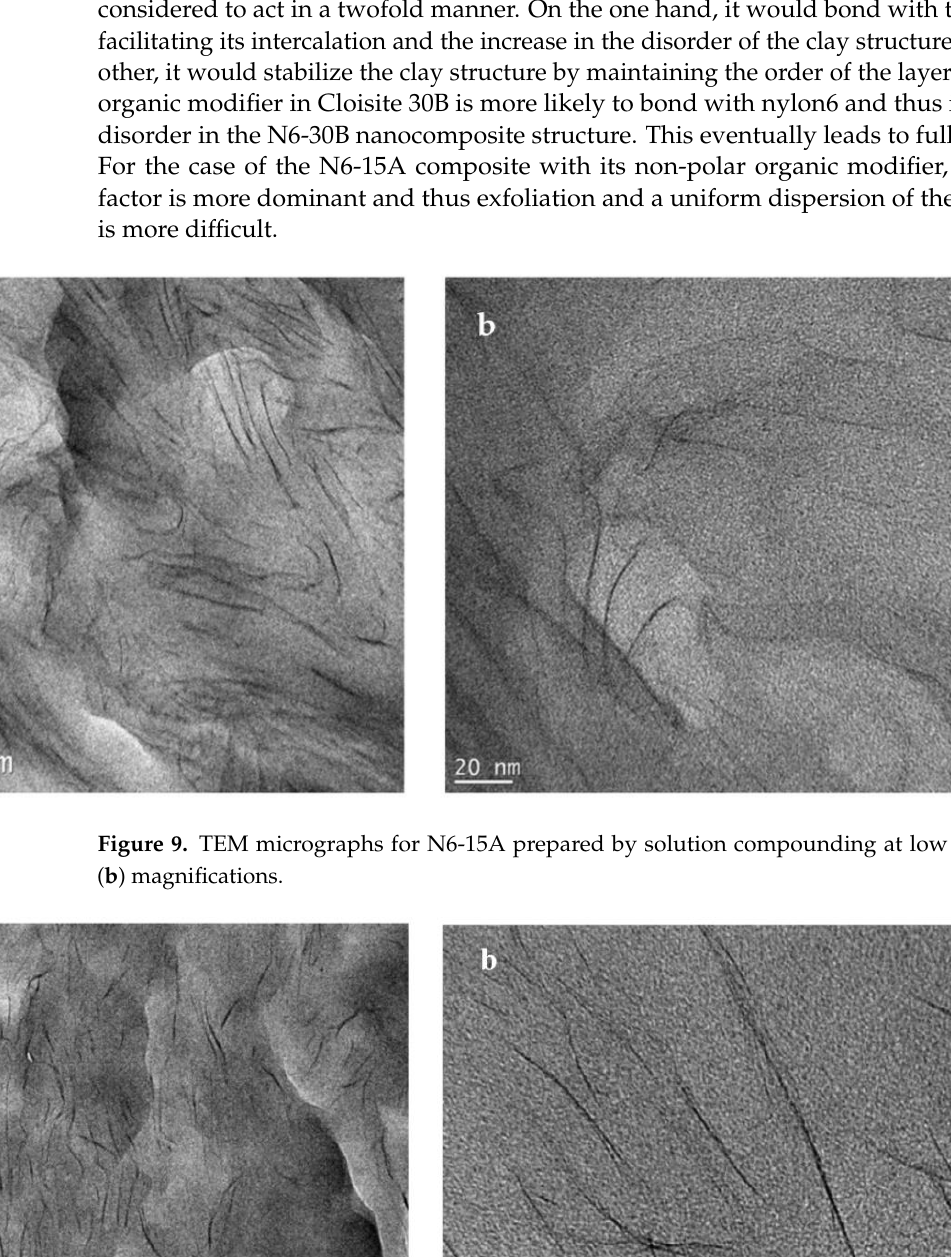
Figure 8. TEM micrographs for N6-Na + prepared by solution compounding at low ( a ) and high ( b ) magnifications.